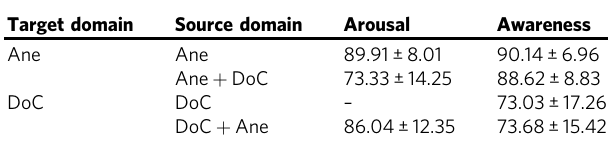
Table 3 Averaged single-trial classi fi cation accuracy (%) in pharmacological and pathological conditions for resting- state EEG: this represents the accuracy ± standard